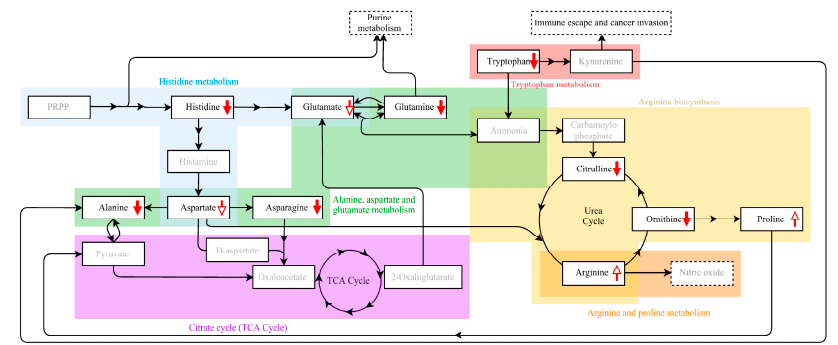
Figure 3. Metabolic pathways proposed to be associated with ovarian cancer (OC) and amino acids altered in OC patients. Red filled arrows represent the concentration of a particular metabolite significantly altered in OC patients ( p -value < 0.05), red empty arrows indicate the change in concentration of a particular metabolite in OC patients that was not statistically significant ( p -value > 0.05). The crucial intermediates connecting the proposed amino acids and different metabolic pathways are presented in grey. Dotted rectangles represent the endpoint products, pathways or